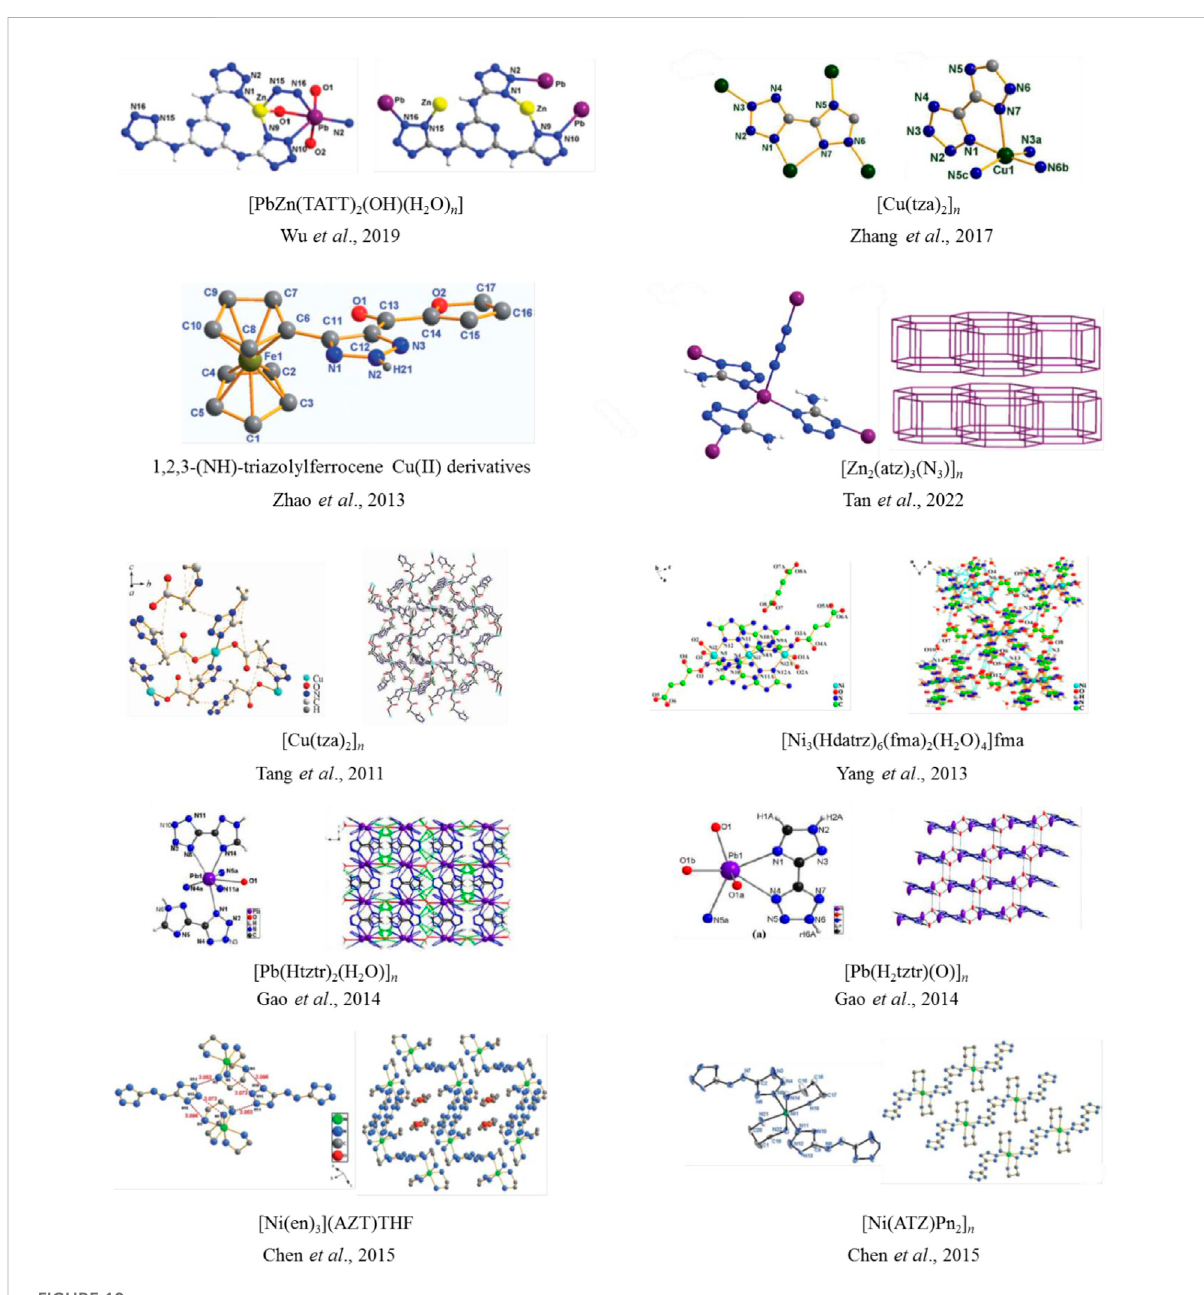
FIGURE 10 The typical EMOFs structural